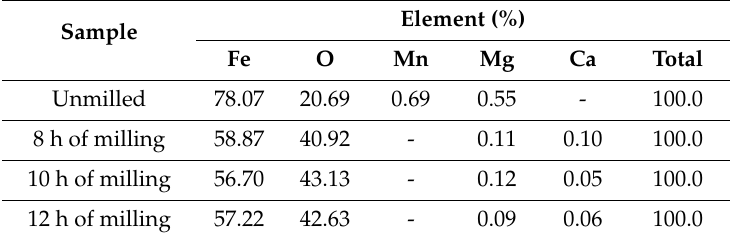
Table 2. Quantitative analysis of recycled α -Fe 2 O 3